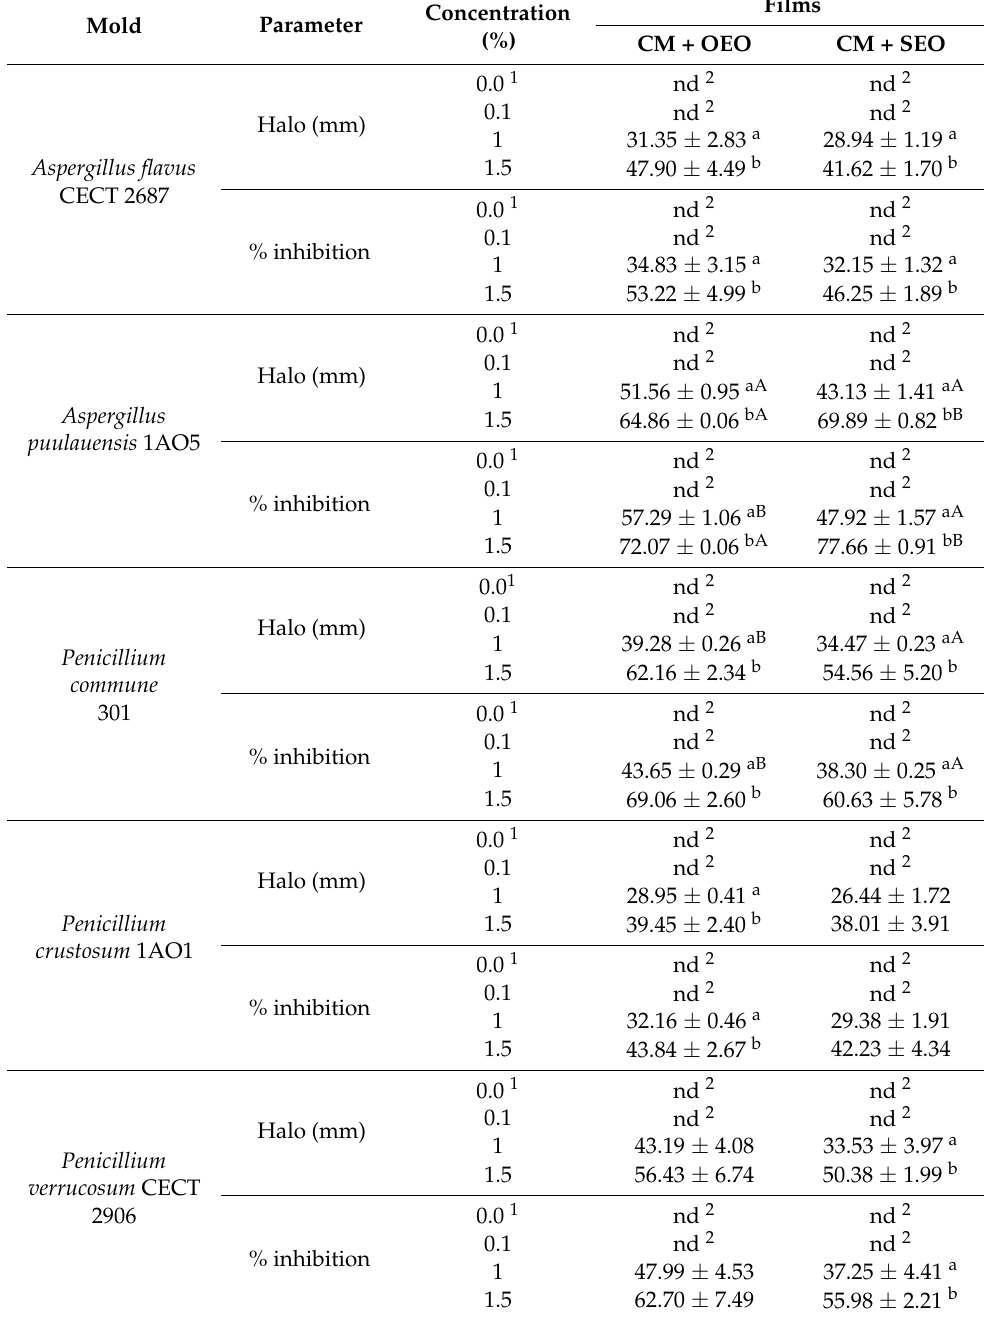
Table 3. Effect of oregano (OEO) or savory (SEO) essential oil addition in the antifungal activity (halos and percentage of inhibition) of the chia mucilage films (CM) (mean ± sd).